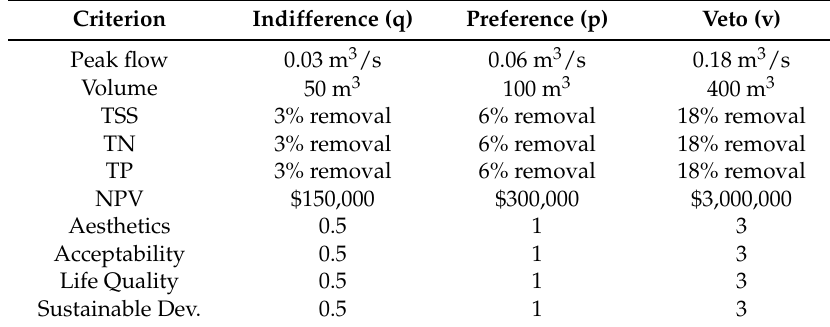
Table 11. Criteria threshold